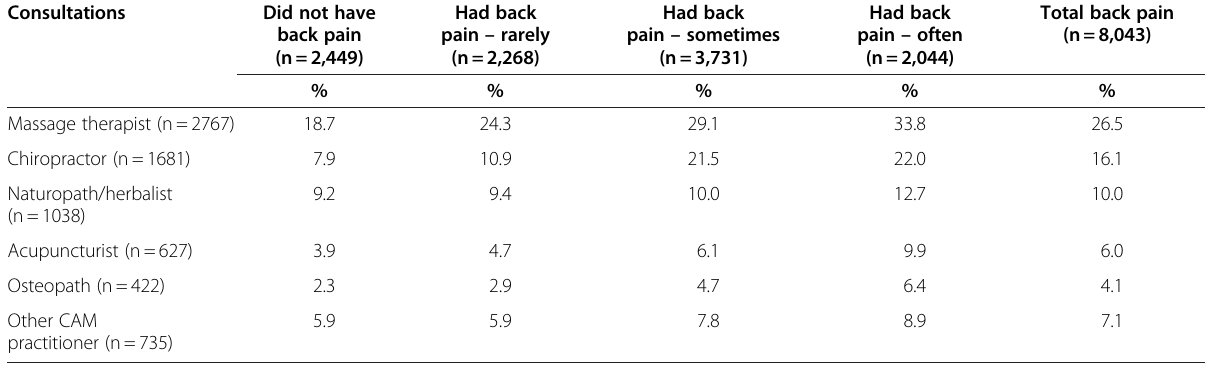
Table 2 Back pain status by consultations with individual CAM practitioner groups